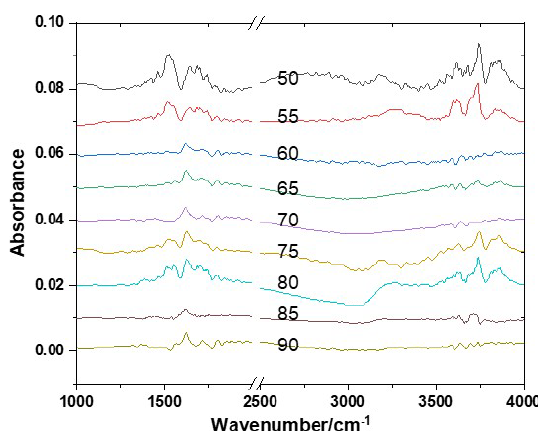
Figure 4. The same as Fig. 2 but for OA